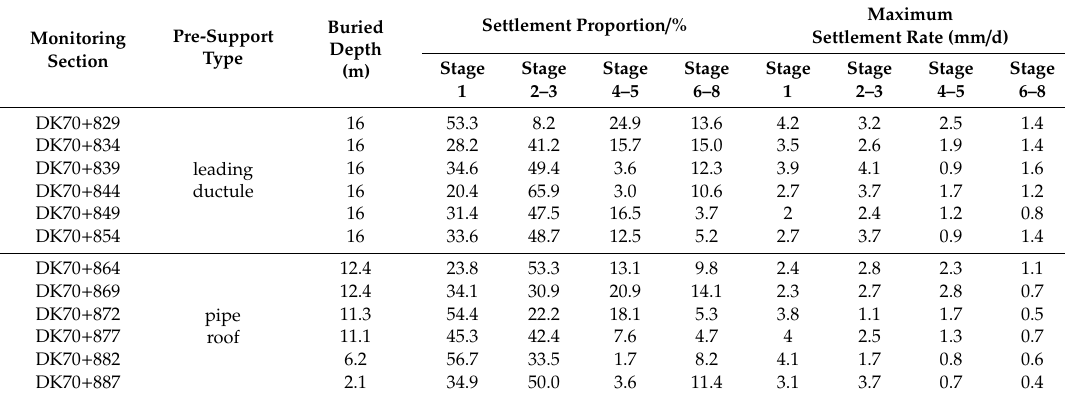
Figure 11. Final monitoring values of tunnel displacement. Table 4. Settlement proportion and maximum settlement